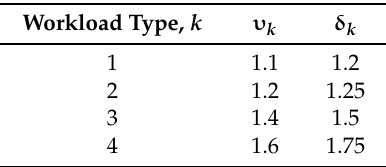
Table 2. Model parameters used in the simulation